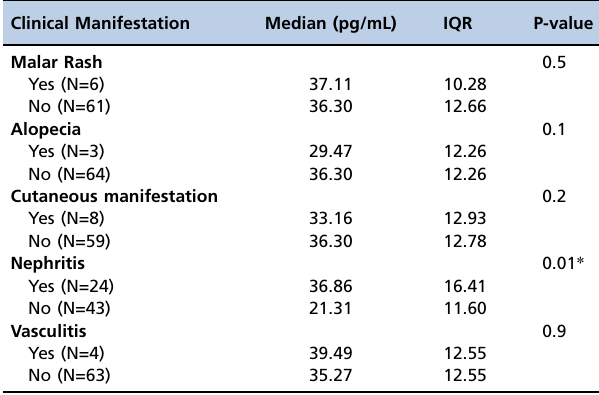
Table 2 - Serum IL-17 levels compared with the main clinical